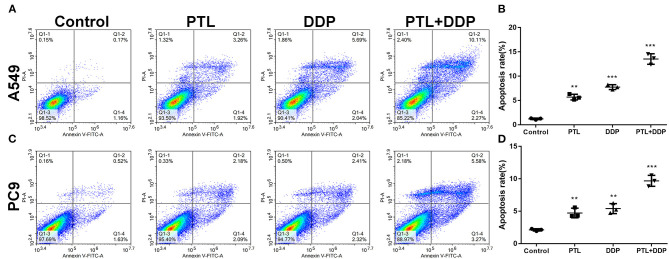
Effect of PTL, DDP alone, and in combination on apoptosis. Representative profiles showing apoptosis in A549 (A) or PC9 cells (C) treated with 30 μM PTL, 0.75 μM DDP alone, and 0.2 μM DDP and 10 μM PTL in combination for 48 h. Data represent the cell population in cell cycle arrest of A549 (B) and PC9 (D) cells. All data are shown as the mean ± SD of three independent experiments. **P < 0.01, ***P < 0.001 vs. the control group.